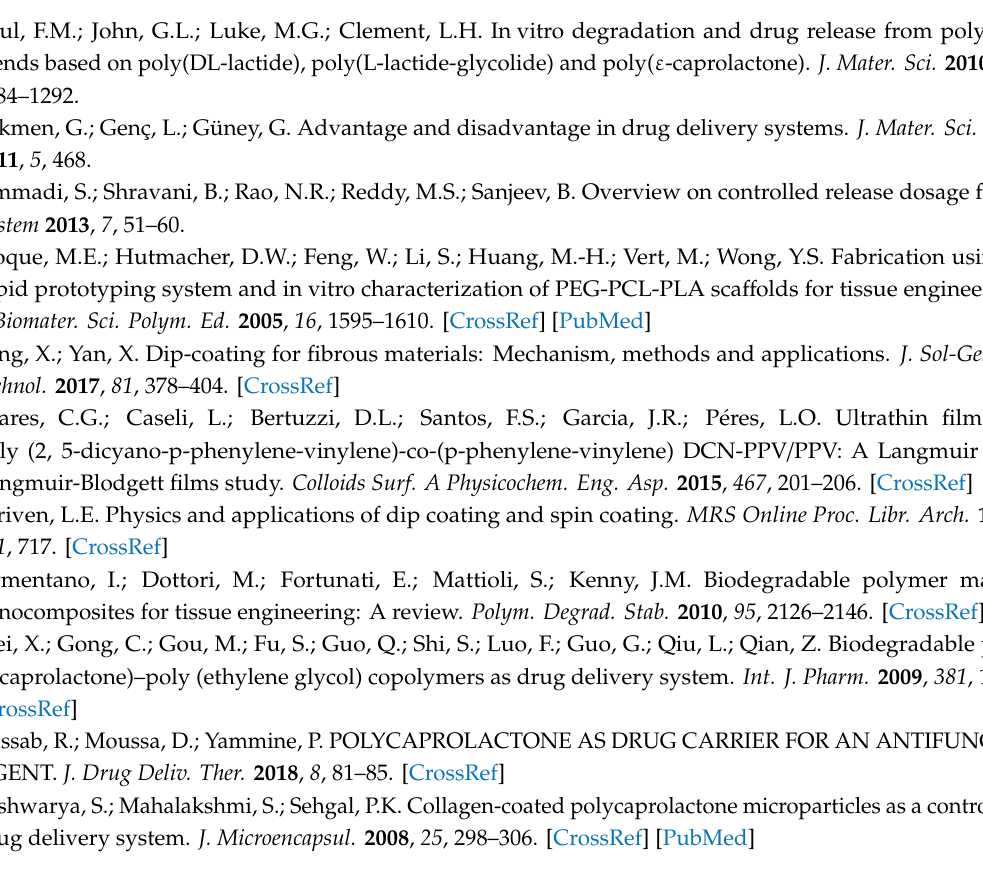
Figure S1: EDS_supplementary, Figure S2: ATR